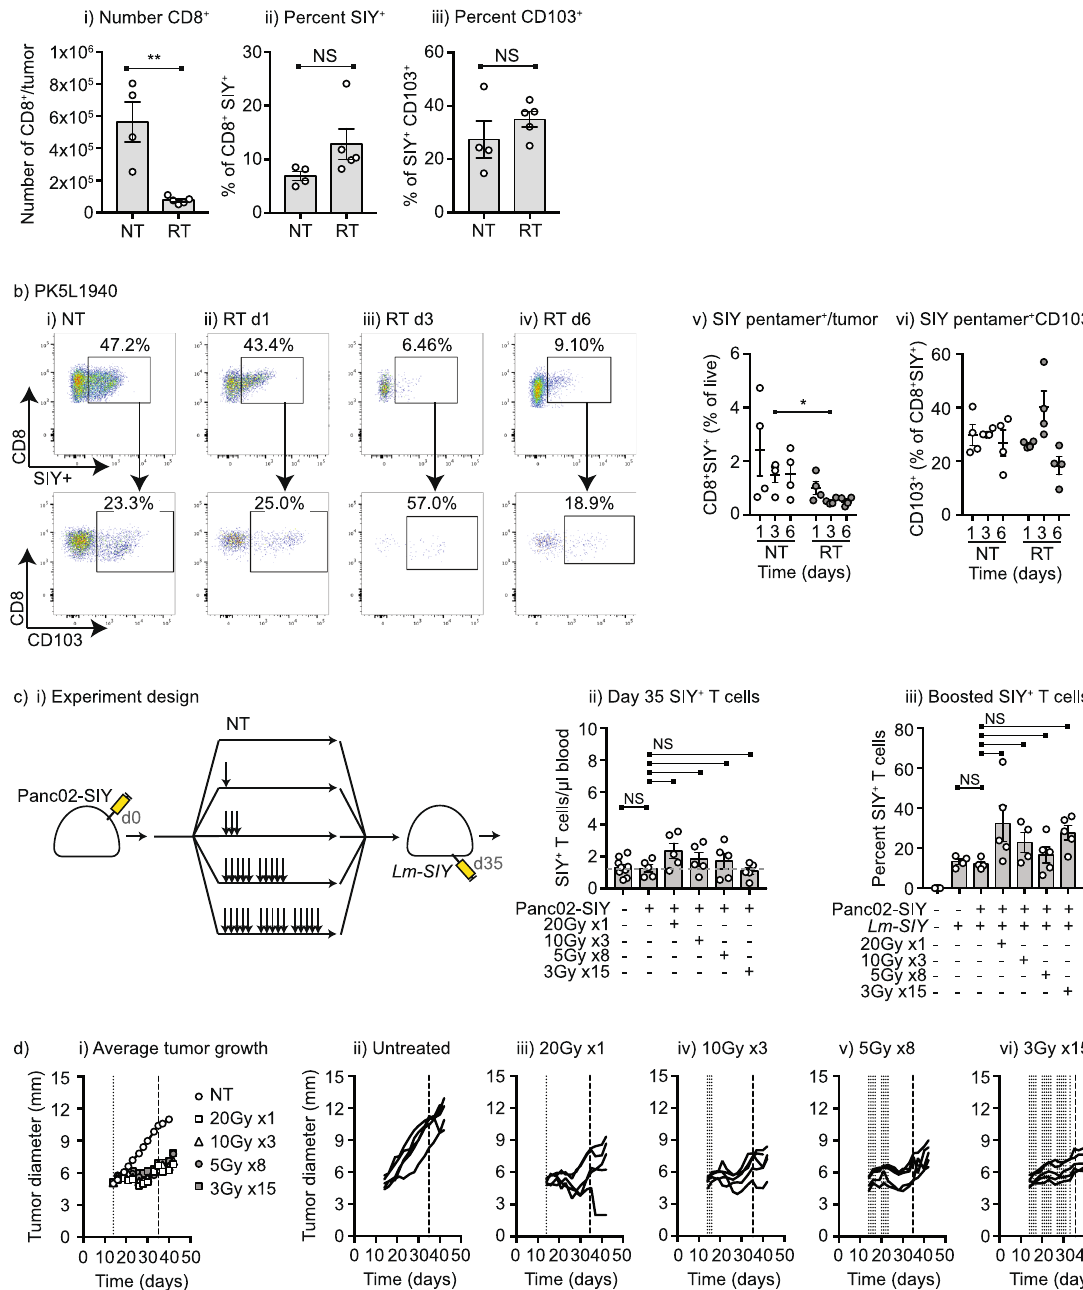
Figure 5. Radiation therapy to the tumor decreases but does not eliminate resident memory T cells. ( a ) i) Panc02-SIY tumors were implanted into C57BL/6 mice and left untreated (NT) or treated with 20 Gy focal RT on d14. Tumors were harvested 3 days later for analysis of tumor infiltrating i) CD8 T cells and ii) SIY-specific T cells. iii) CD103 expression in SIY-specific T cells. ( b ) PK5L1940 tumors were implanted into C57BL/6 mice and left untreated or treated with 20 Gy focal RT on d17. Tumors were harvested from i) untreated mice or ii) 1d, iii) 3d or iv) 6d following radiation therapy and analyzed for expression of CD103 in the SIY-specific tumor- infiltrating T cells. v) Summary of SIY-specific T cells per tumor. vi) Summary of CD103 expression in SIY- specific T cells. ( c ) i) Panc02-SIY tumors were implanted into C57BL/6 mice and left untreated (NT) or starting on d14 treated with a range of radiation schemes with equivalent BED. ii) At d35 following tumor challenge – at completion of all treatment schemes – mice were analyzed for SIY-specific T cells in the peripheral blood compared to naïve control mice. iii) Mice were subsequently challenged with Lm-SIY to boost antigen specific responses and analyzed 5 days later for SIY-specific T cells in the peripheral blood compared to naïve control mice. ( d ) i) Average tumor growth of mice treated as in c). Graphs show individual tumor responses in ii) untreated mice or mice treated with iii) 20 Gy x1; iv) 10 Gy x3; v) 5 Gy x8; or vi) 3 Gy x15. Key: * p < 0.05; ** p < 0.01; *** p < 0.001; **** p < 0.0001; NS = not